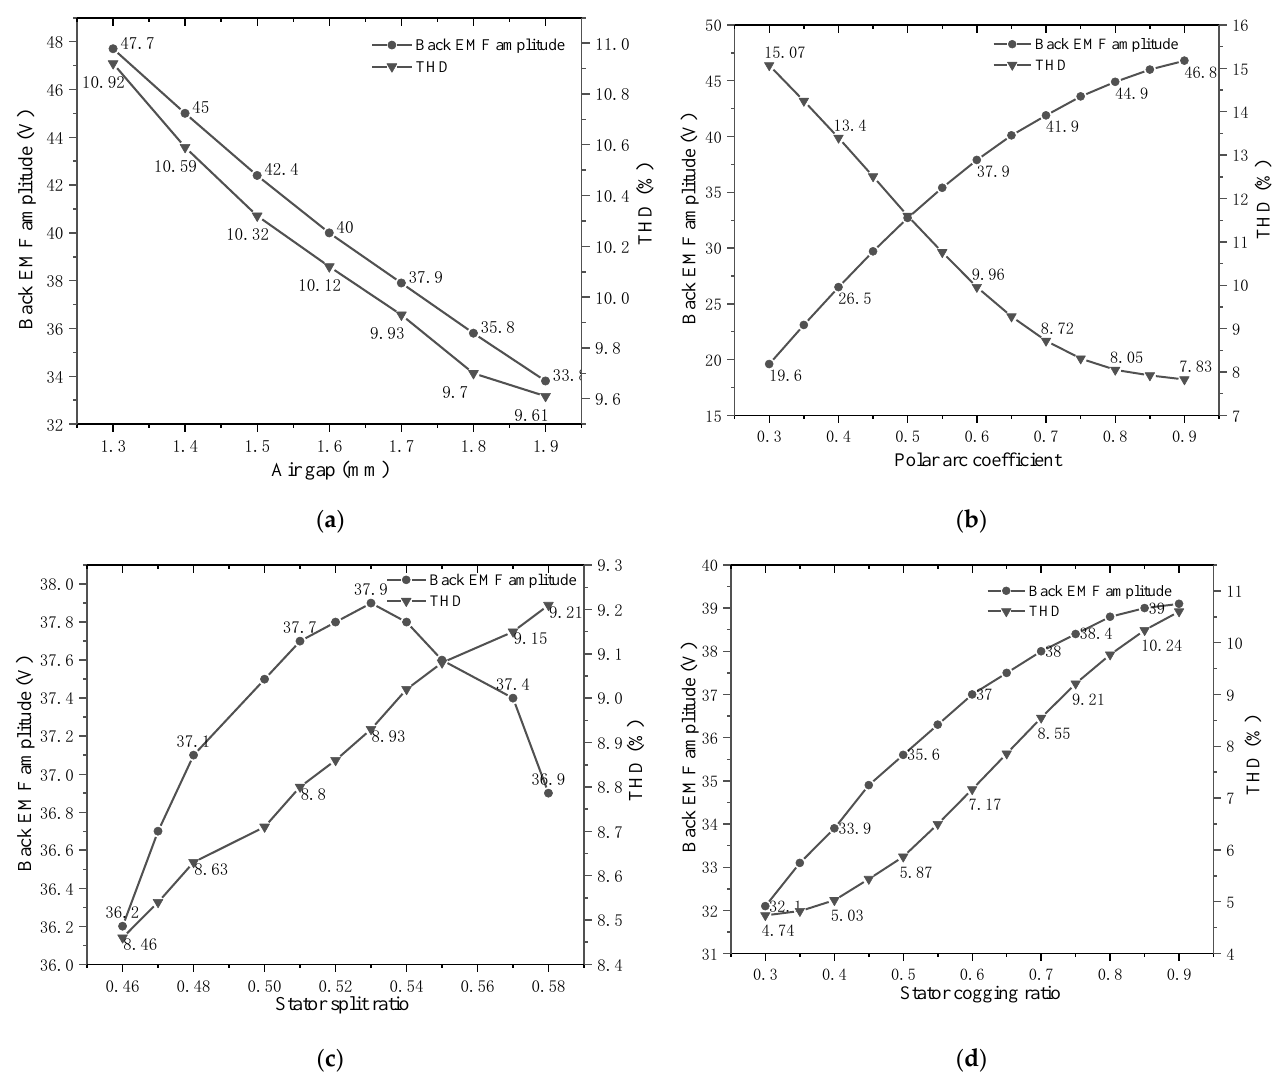
Figure 4. ( a ) Air gap optimization; ( b ) Polar arc coefficient optimization; ( c ) Stator split ratio opti- mization; ( d ) Stator cogging ratio optimized.